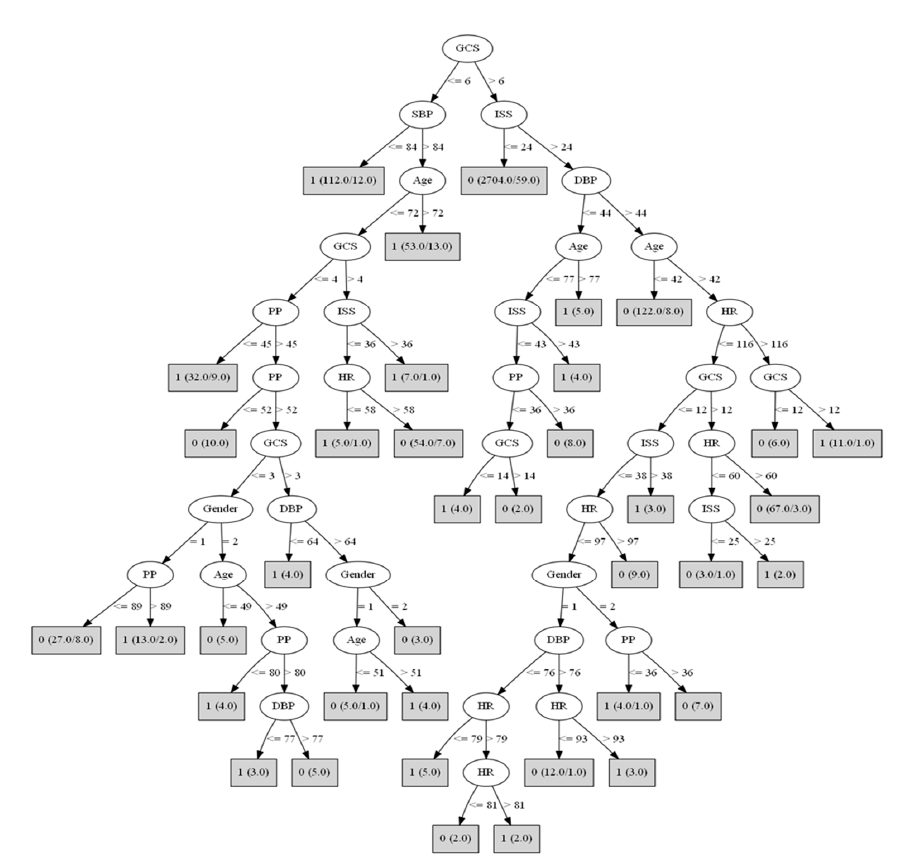
Table 3. Confusion matrix of J48 algorithms.